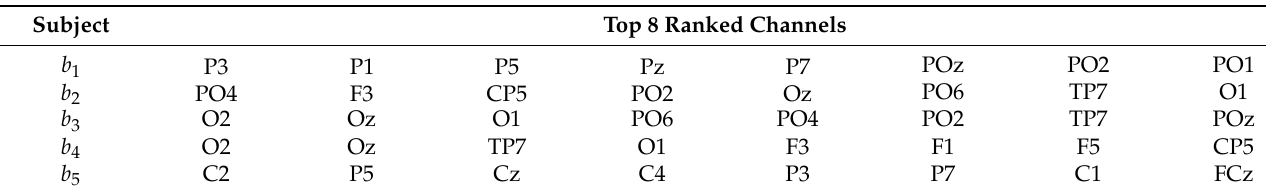
Table 1. The top 8 ranked channels for each